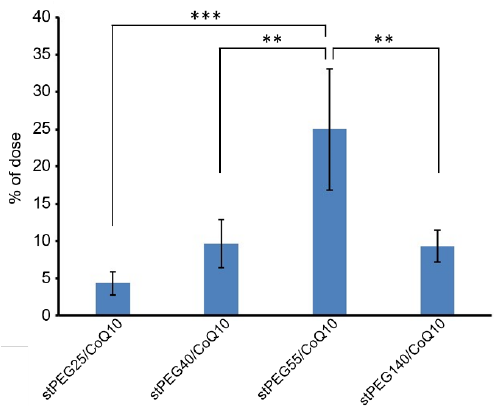
Figure 3. Result of 2,2-diphenyl-1-picrylhydrazyl (DPPH) radical scavenging assay. Inhibition of DPPH radical by stPEG/CoQ10 micelles at 1 mg/mL ( A ) and 2 mg/mL ( B ) as CoQ10 equivalents. The values are the means ± S.D. for groups, with the experiment performed in triplicate for each sample; * p < 0.05.